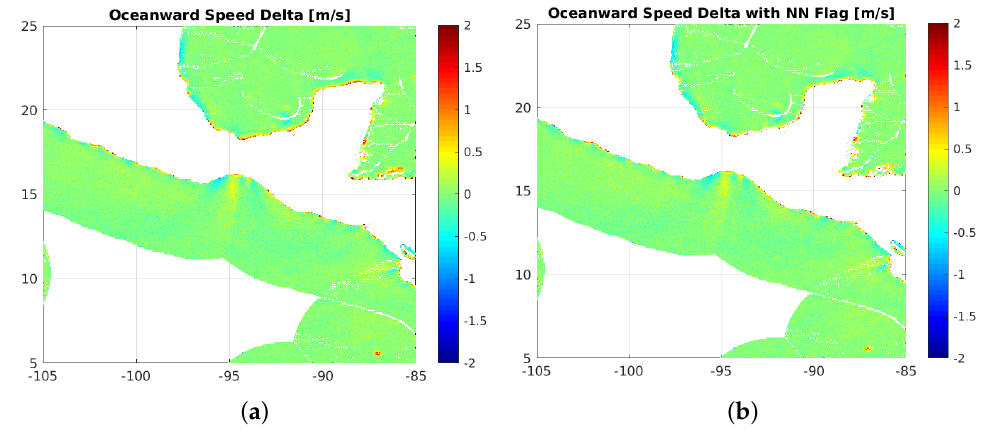
Figure 6. ( a ) Map of average coastal wind speed bias as compared to that WVC’s oceanward neighbors. ( b ) Same with data flagged as poor coastal processing by this neural network